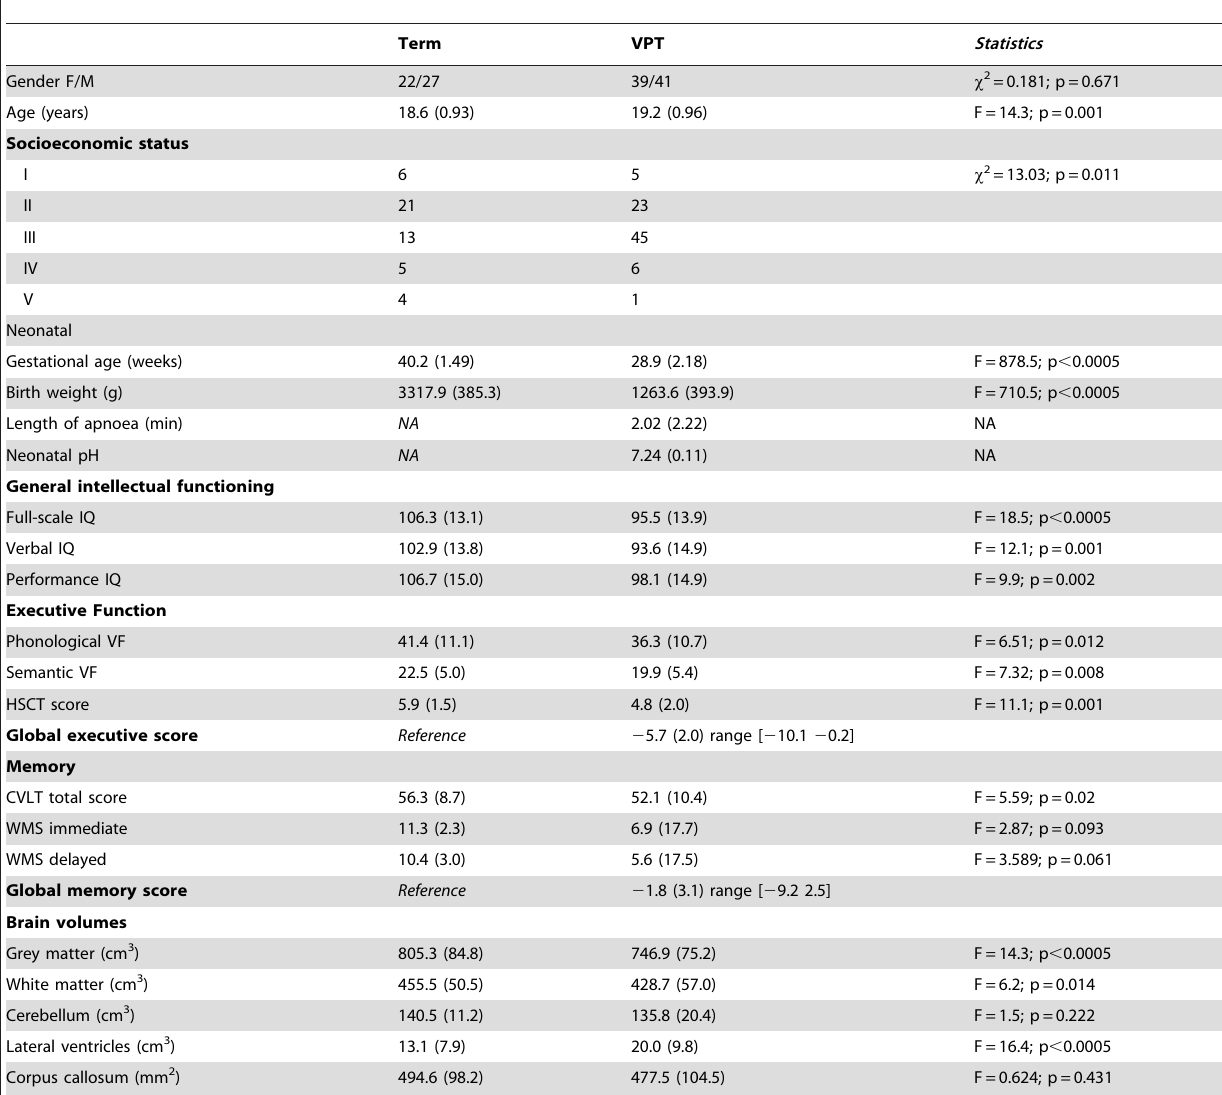
Table 1. Demographic details, cognitive function and neuroimaging measures for VPT and Term